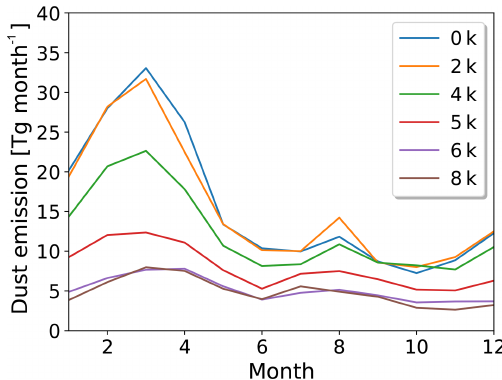
Figure 10. Mean seasonal cycle of simulated dust emissions in the western Sahara (15 ◦ W–2 ◦ E, 18–29 ◦ N) for all time